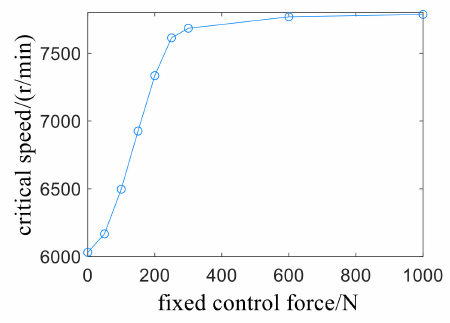
Figure 23. Relationship between first critical speed and fixed control